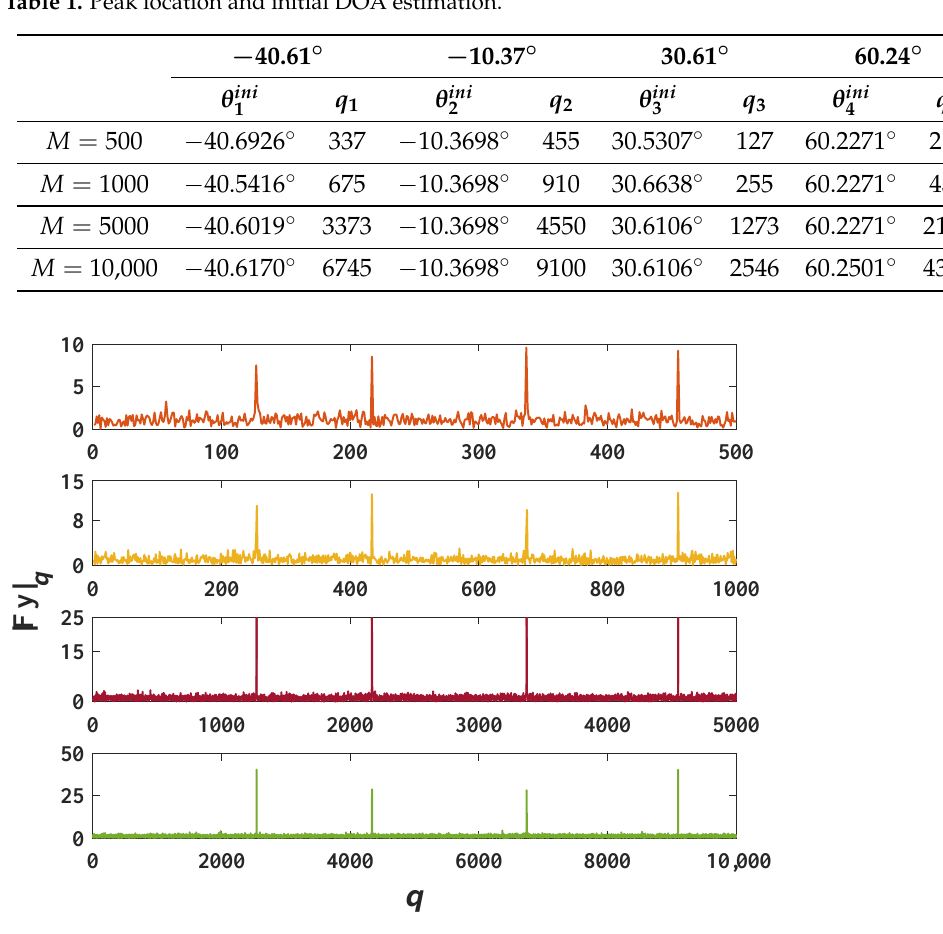
Figure 3. The DFT spectrum | Fy | of y